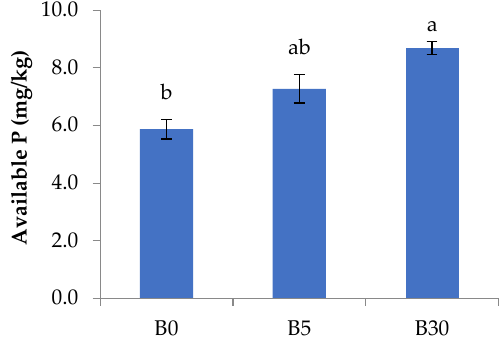
Figure 2. Available phosphorus in soil of lower layer under biochar amendment to the upper layer. Bars indicates the means and standard errors (n = 3). Different letters indicate the significant difference ( p < 0.05) among treatments by Tukey’s HSD test.